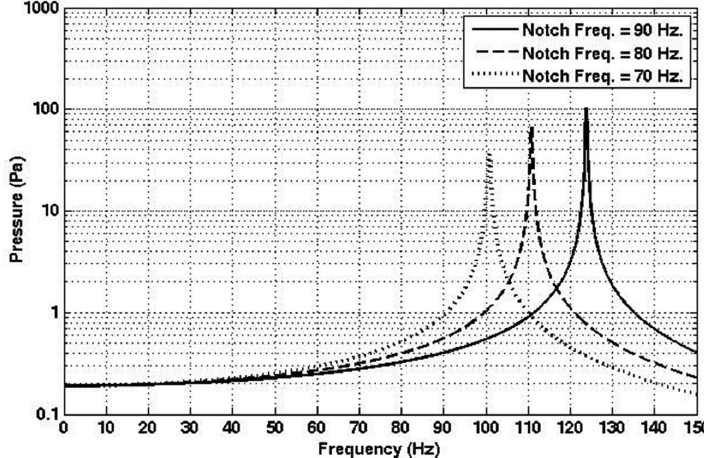
Fig. 9. Bottom chamber pressure in the hydraulic engine mount.